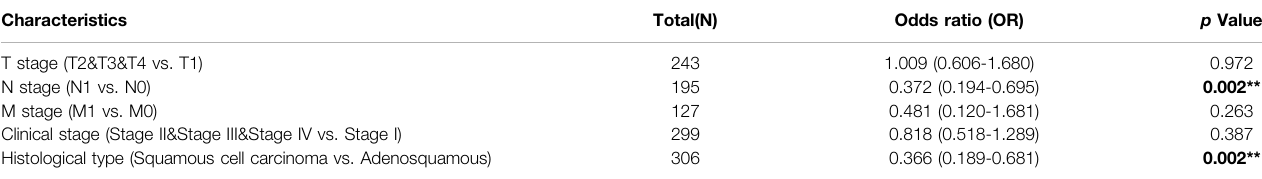
TABLE 2 | Logistic regression analysis of association between clinicopathological characteristics and TMEM33 expression in CESC patients. Characteristics Total(N) Odds ratio (OR) p